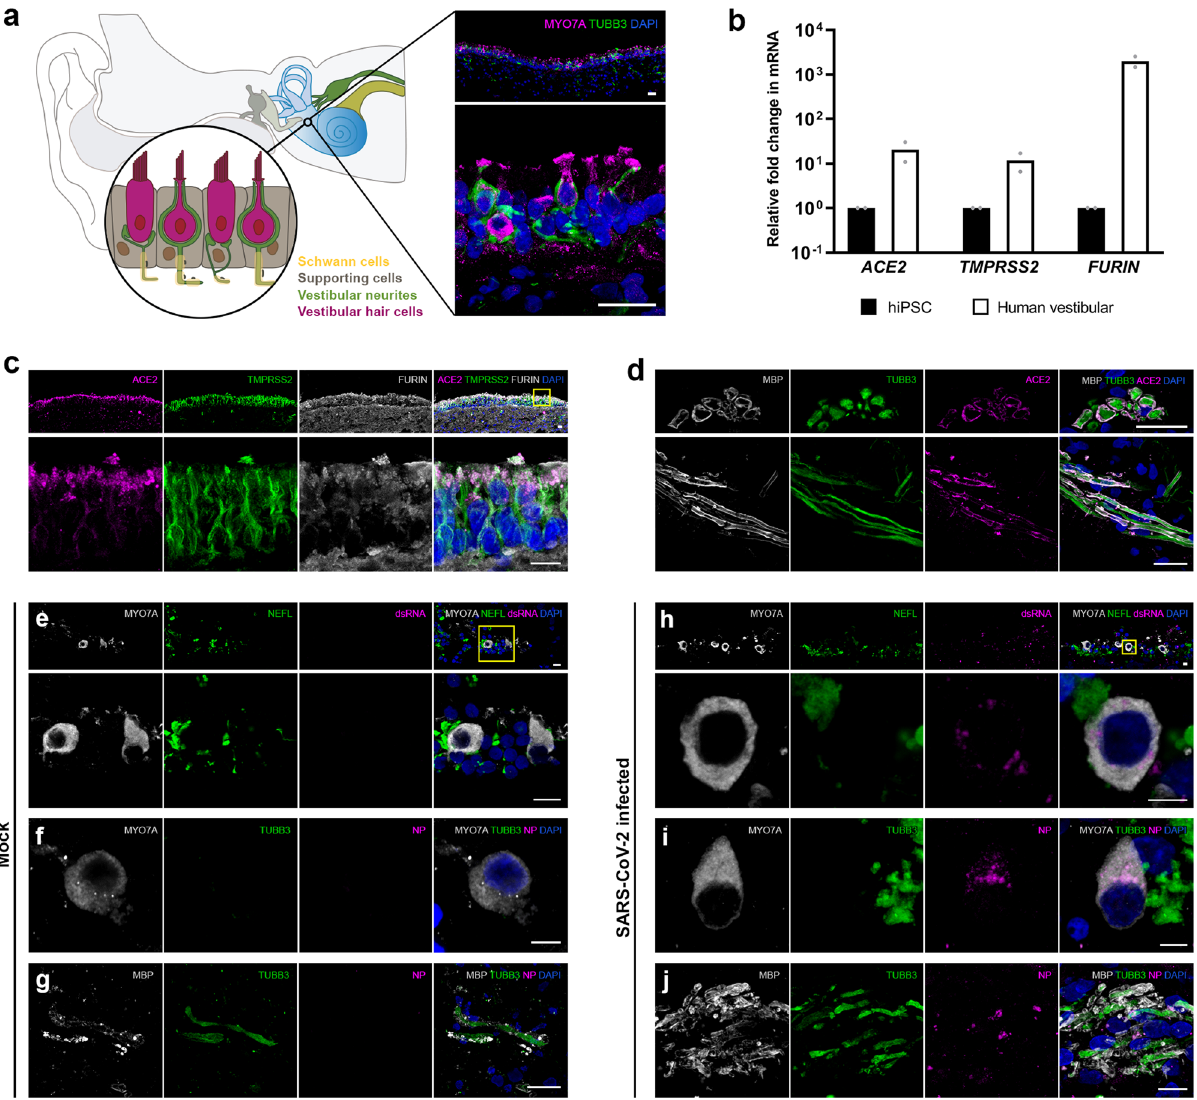
Fig. 2 Expression of SARS-CoV-2 cell entry-related receptor and entry-associated proteases in human peripheral vestibular tissue. a Surgical specimens of human vestibular end organs from the inner ear include vestibular hair cells expressing MYO7A, supporting cells, Schwann cells, and vestibular neurons expressing TUBB3. Scale bar = 20 μ m. b mRNA expression of ACE2 , TMPRSS2 , and FURIN in human vestibular tissue relative to expression in hiPSCs. Individual gene expression levels in hiPSCs were set to 1. N = 2 biological replicates, 3 technical replicates; ** P < 0.01, **** P < 0.0001; mean ± SEM. c Protein co-expression of ACE2, TMPRSS2, and FURIN in hair cells. Nuclei are stained with DAPI. In the overview of upper images, the rectangle is shown at a higher magni fi cation. Scale bars = 10 μ m. Representative images are from 2 biological replicates and at least 5 technical replicates with similar results. d Protein expression of ACE2 in Schwann cells. MBP is Schwann cell marker. Upper images show the cross-sectioned Schwann cells expressing ACE2. Representative images from 2 independent experiments with similar results. Scale bars = 20 μ m. e – j Immuno fl uorescent staining of mock-infected ( e – g ) and SARS-CoV-2-infected human vestibular tissue ( h – j ). J2 staining of viral double-stranded RNA (dsRNA) and viral nucleoprotein (NP) expression in hair cells, Schwann cells, and not in neurons. Representative images from 2 biological replicates. Scale bars = 5 μ m ( f , h , i ), 10 μ m ( e , j ), 20 μ m ( g